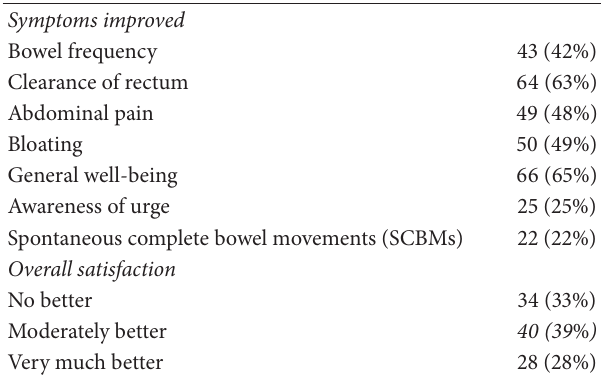
Table 3: Symptom improvement and overall satisfaction with transanal irrigation